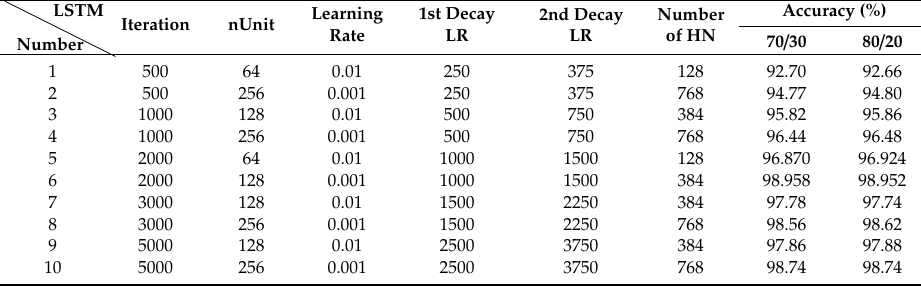
Table 6. Estimation accuracy of stroke disease by LSTM network structure